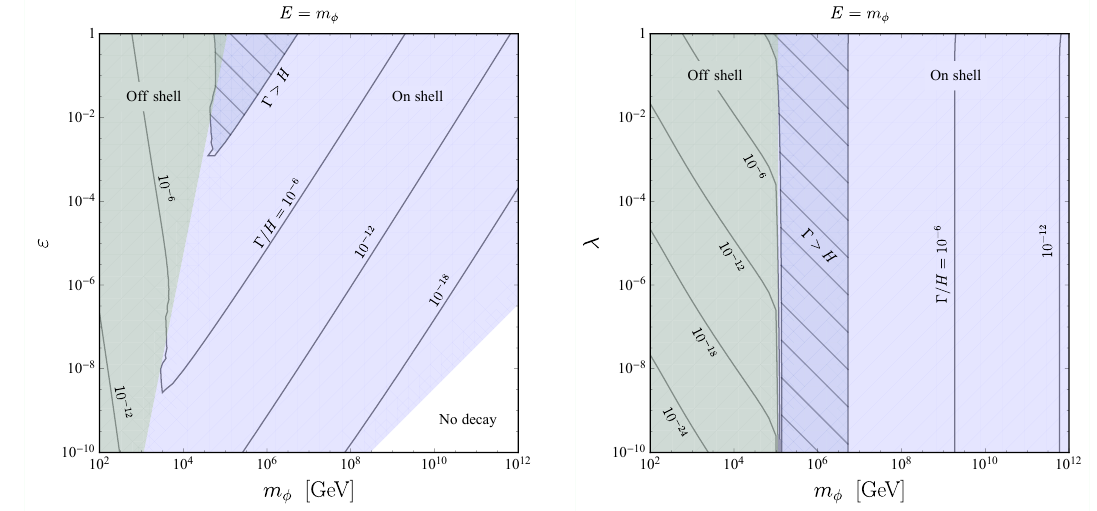
Figure 6 . The coupling dependence of the zero mode decay width. The blue (“on shell”) region means the initial energy is above the threshold. In the green (“off shell”) region, only the two-body decay is possible. The on-shell decay width does not depend on λ as it should be. For the “no decay” region, see the text for